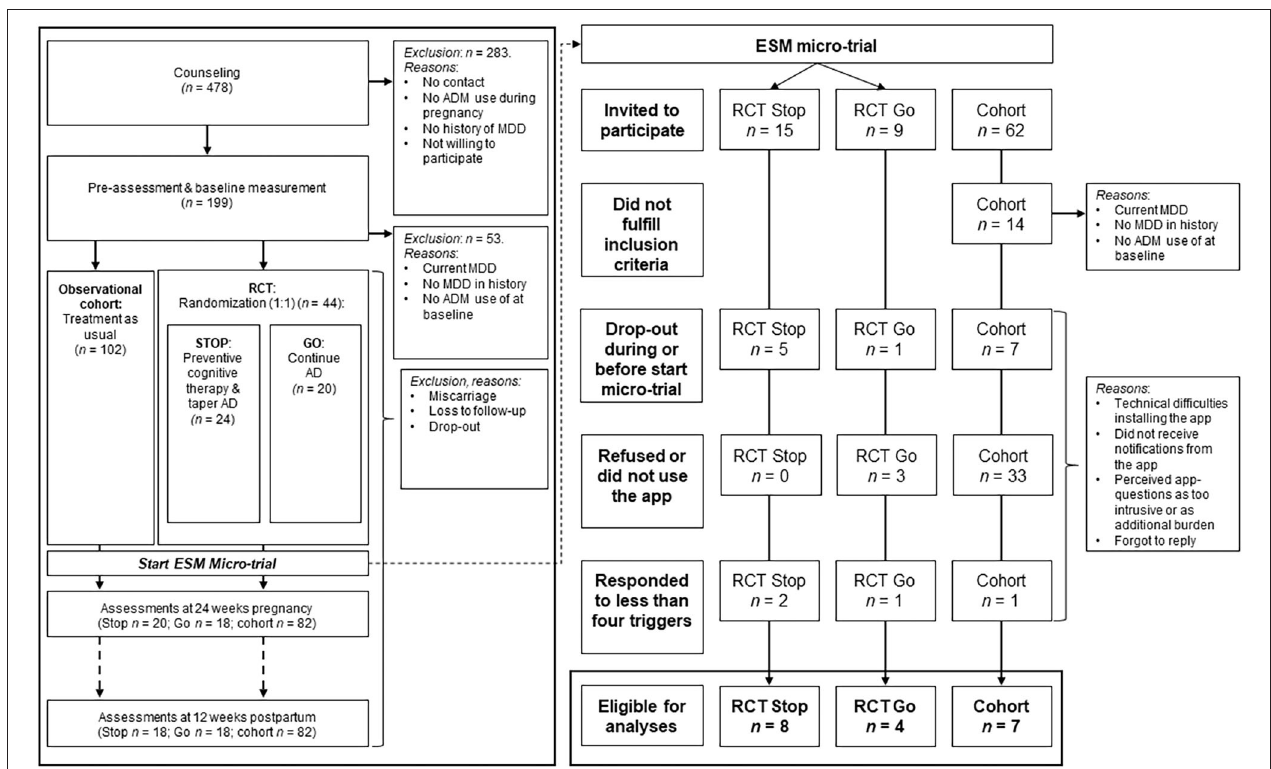
FIGURE 1 | Flow chart of study participation and exclusion (reasons). RCT, Randomized controlled trial; RCT Stop, RCT group receiving preventive cognitive therapy while tapering ADM; RCT Go, RCT group continuing ADM; ADM, antidepressant medication; ESM, experience sampling